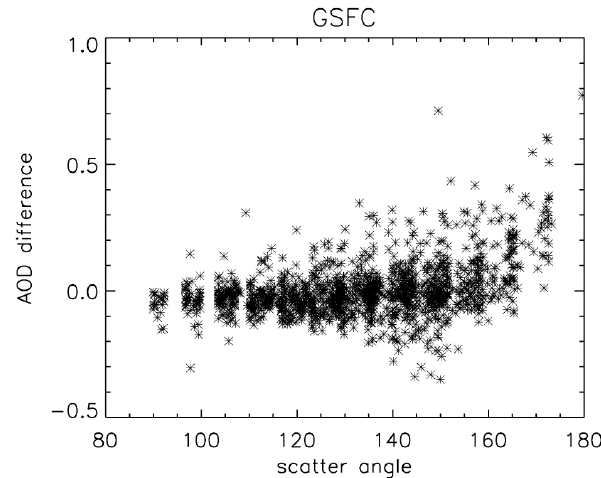
Fig. 3. AOD error vs scatter angle at GSFC site, where AOD error is defined as GOES AOD minus AERONET